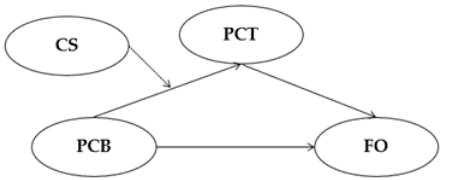
Figure 2. The mediation pathway of Hypothesis 1. Note. PCB = Perceived crime benefit, PCT = Proactive criminal thinking, FO = Future offending, CS = Crime strategy. The bold lines show mediation pathways (Hypothesis 1a), and the dashed line a moderation pathway (Hypothesis 1b).